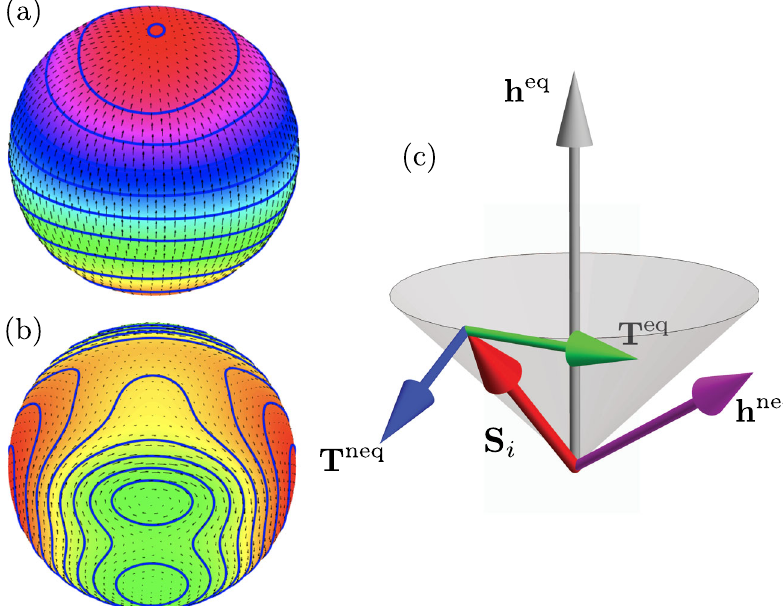
Fig. 1 The Helmholtz-Hodge of vector fi elds on a sphere. A tangential vector fi eld on a sphere can be decomposed into ( a ) the curl-free component ∇ s E and ( b ) the divergence-free component ∇ s ´ G . ( c ) shows the gradient fi eld h eq equilibrium exchange fi eld, and the curl- fi eld h neq ¼ (cid:2) S i ´ ∂ G = ∂ S i , which corresponds to the nonequilibrium force, and their respective i neq ´ S ´ S torques T eq ¼ h eq ¼ h neq i and T i i i i i